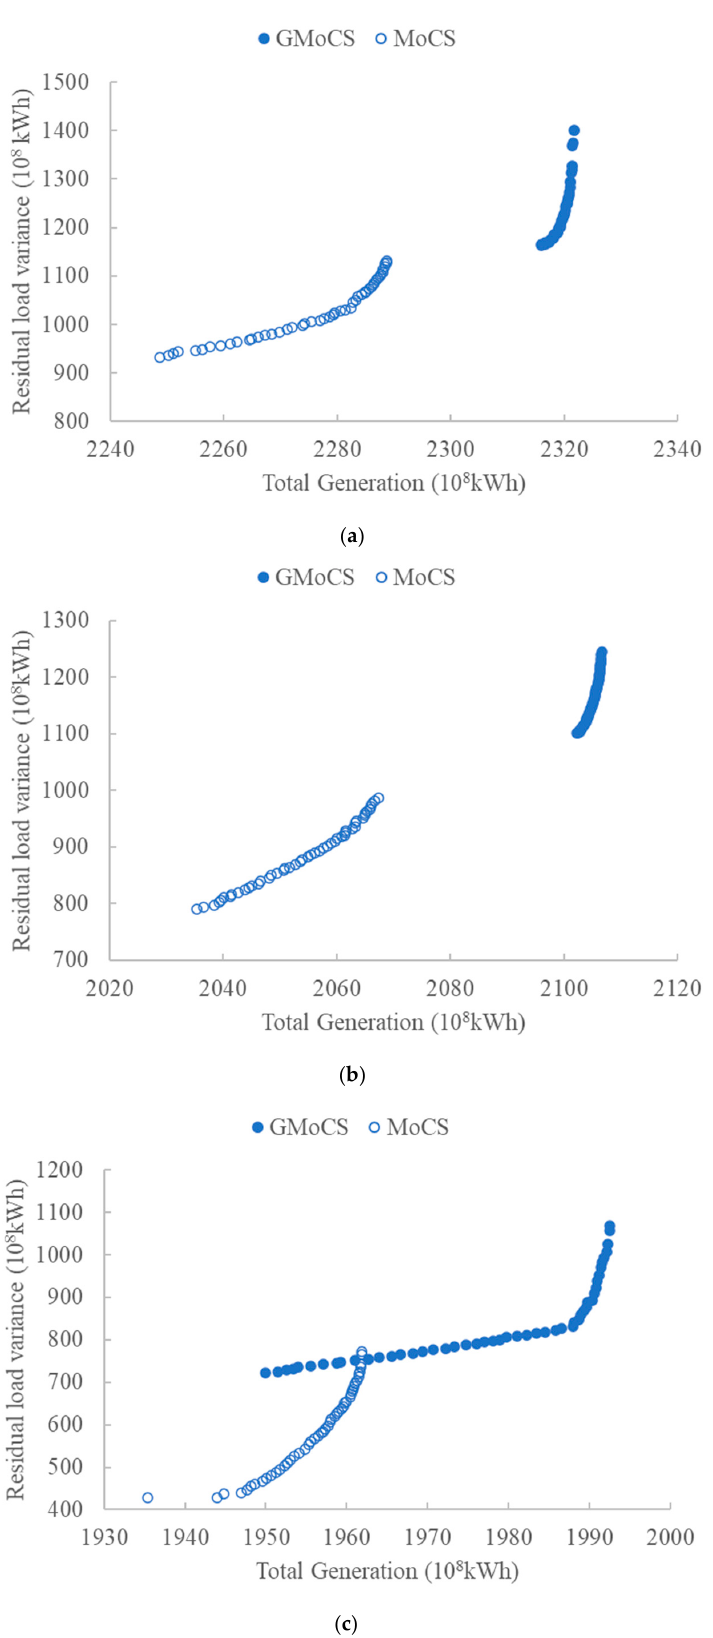
Figure 14. Three typical streamflows of Pingshan station.